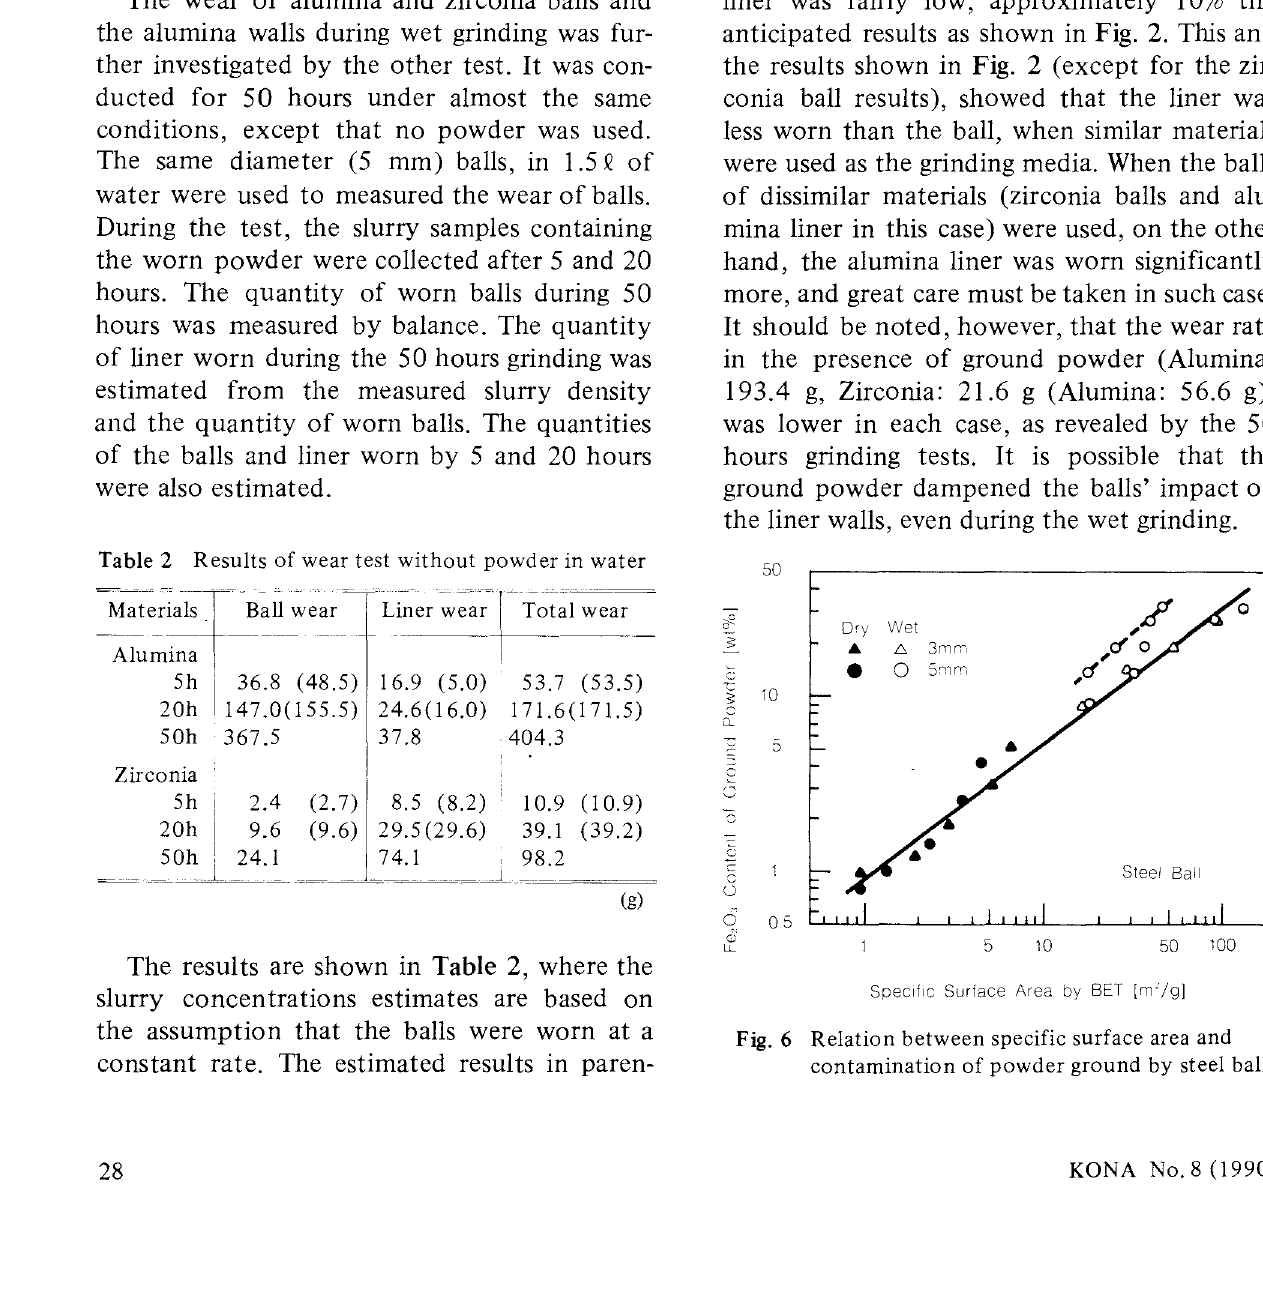
Table 2 Results of wear test without powder in water